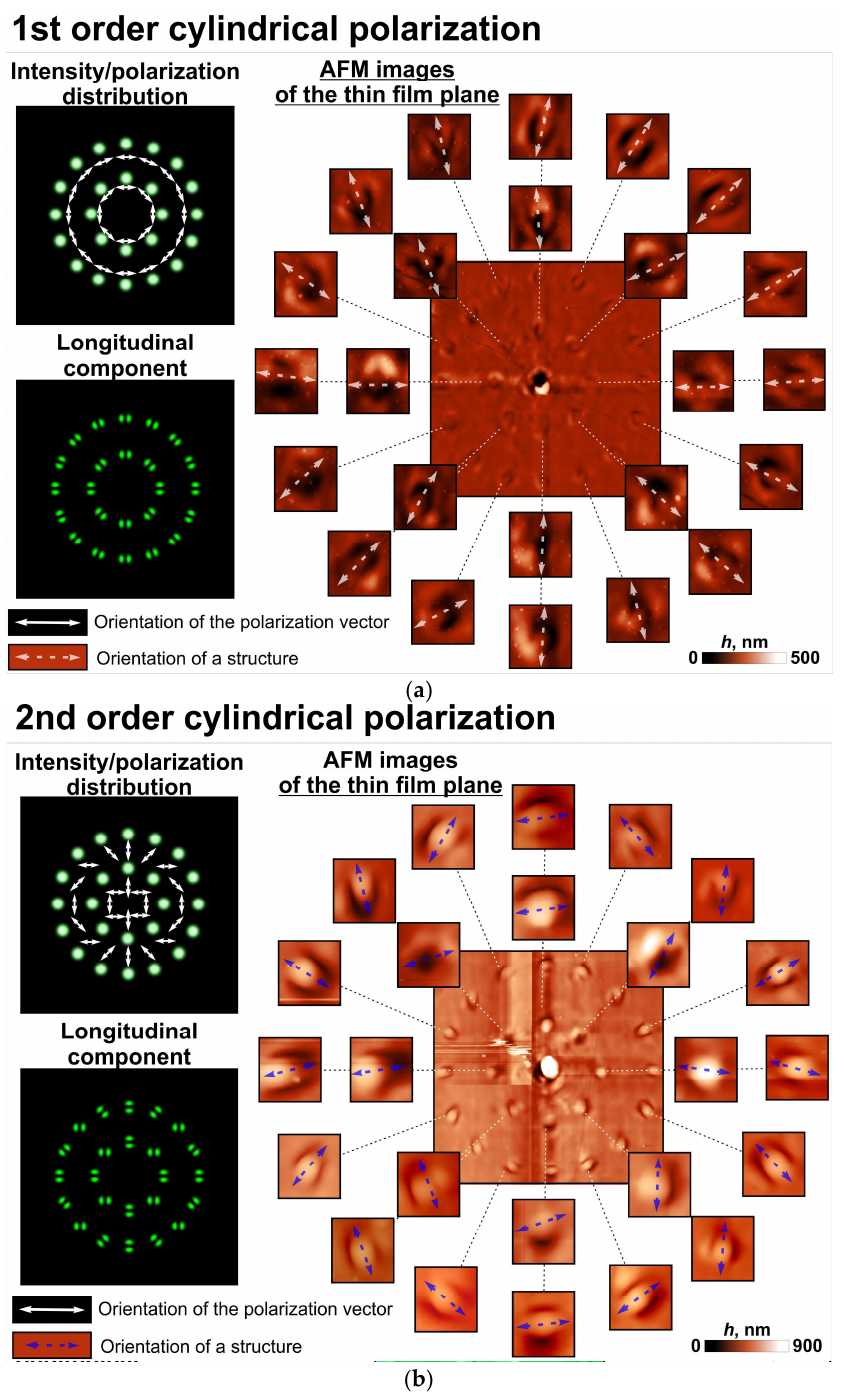
Figure 4. Laser patterning of a thin azopolymer film with a set of modulated polarized spots with non-uniform polarization distributions, which correspond to the first/second order cylindrical polarization. Modeling intensity distributions of the used illuminating laser beams as well as atomic force microscopy (AFM) images of the fabricated microstructures for first-order (azimuthal) cylindrical polarization ( a ), and second-order cylindrical polarization ( b ).